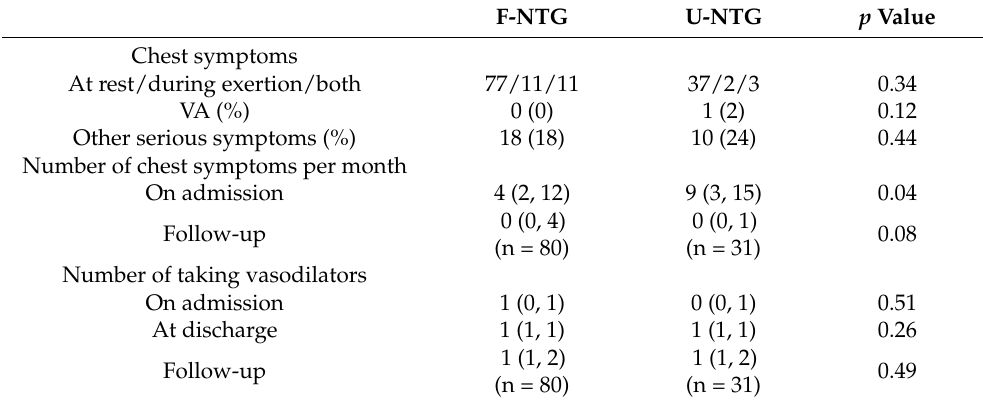
Table 3. VSA-related